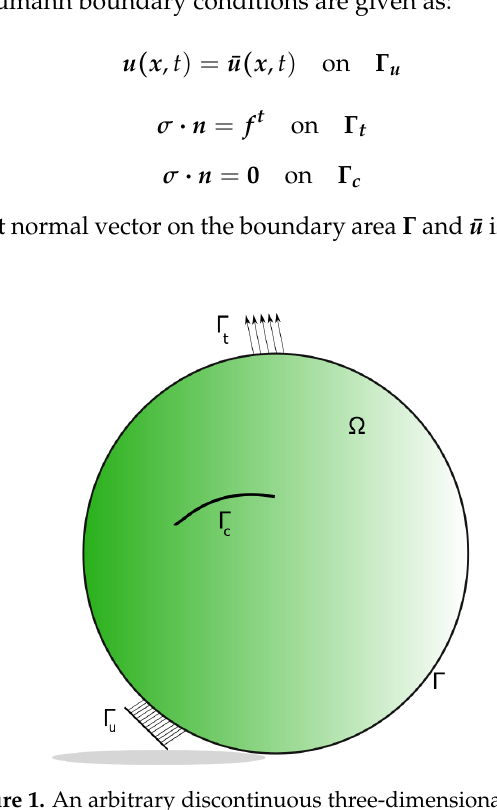
Figure 1. An arbitrary discontinuous three-dimensional